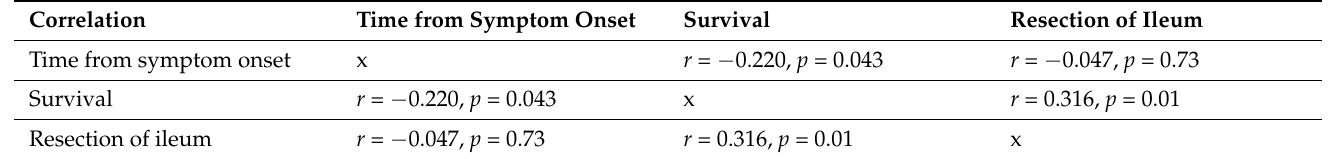
Table 6. Multivariate analysis of “time from symptom onset”, “resection of ileum” and “survival” of